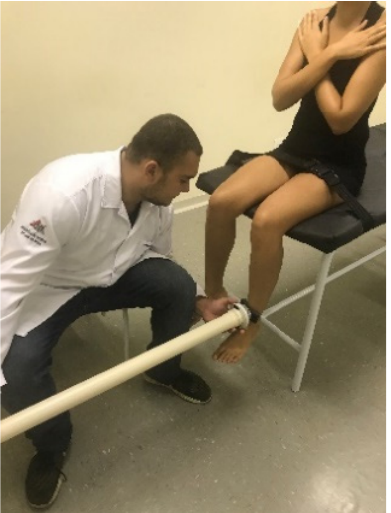
Figure 5 - Knee extensors